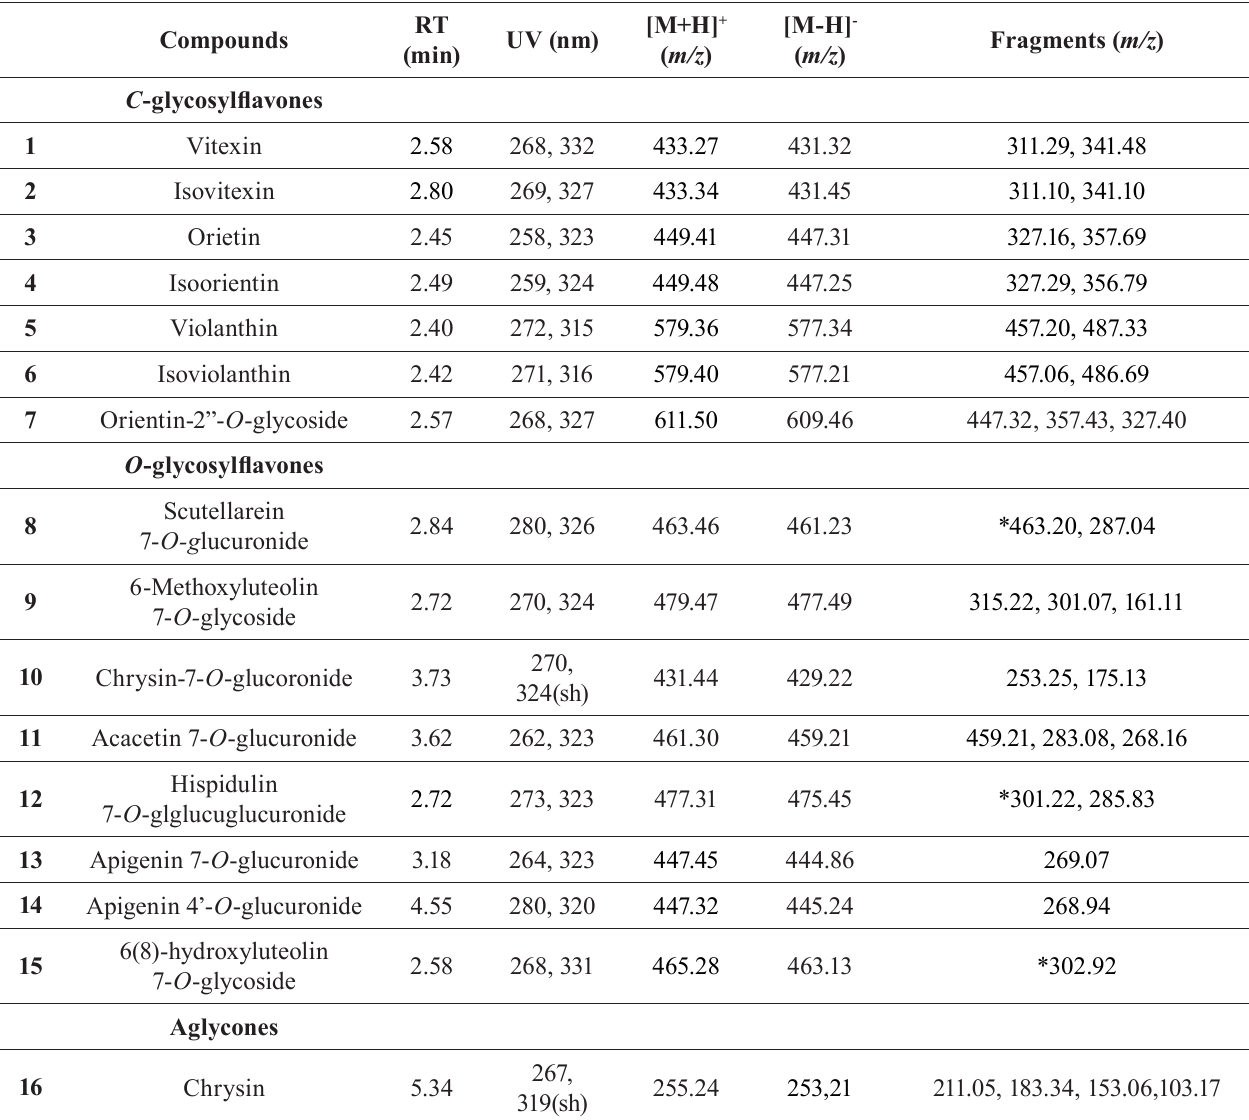
TABLE I - F lavonoids identified in ethanolic extract of leaves from the Fridericia samydoides